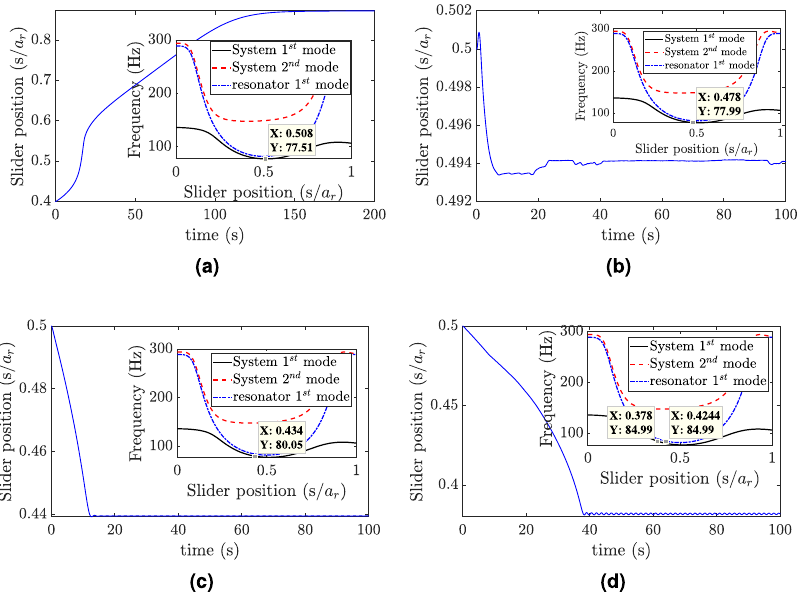
Figure 5. Slider position at different excitation frequencies: ( a ) f = 77 Hz, w 0 = 0.1 g ; ( b ) f = 78 Hz, w 0 = 0.1 g